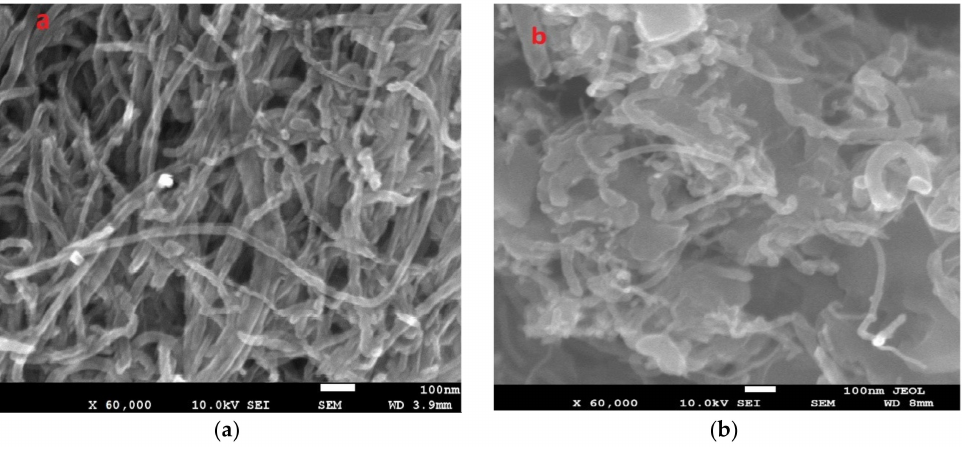
Figure 1. FE-SEM images of the ( a ) multiwalled carbon nanotube (MWCNT) ( b ) MWCNT / cellulose